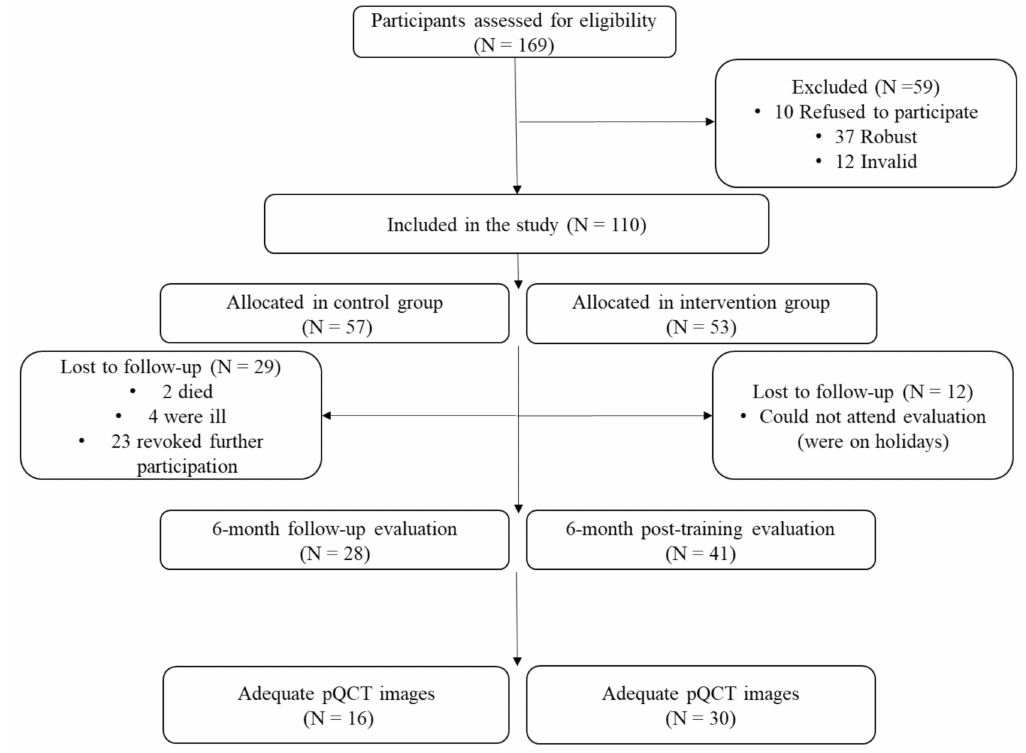
Figure 1. Diagram flow chart of participants. pQCT: Peripheral quantitative computed